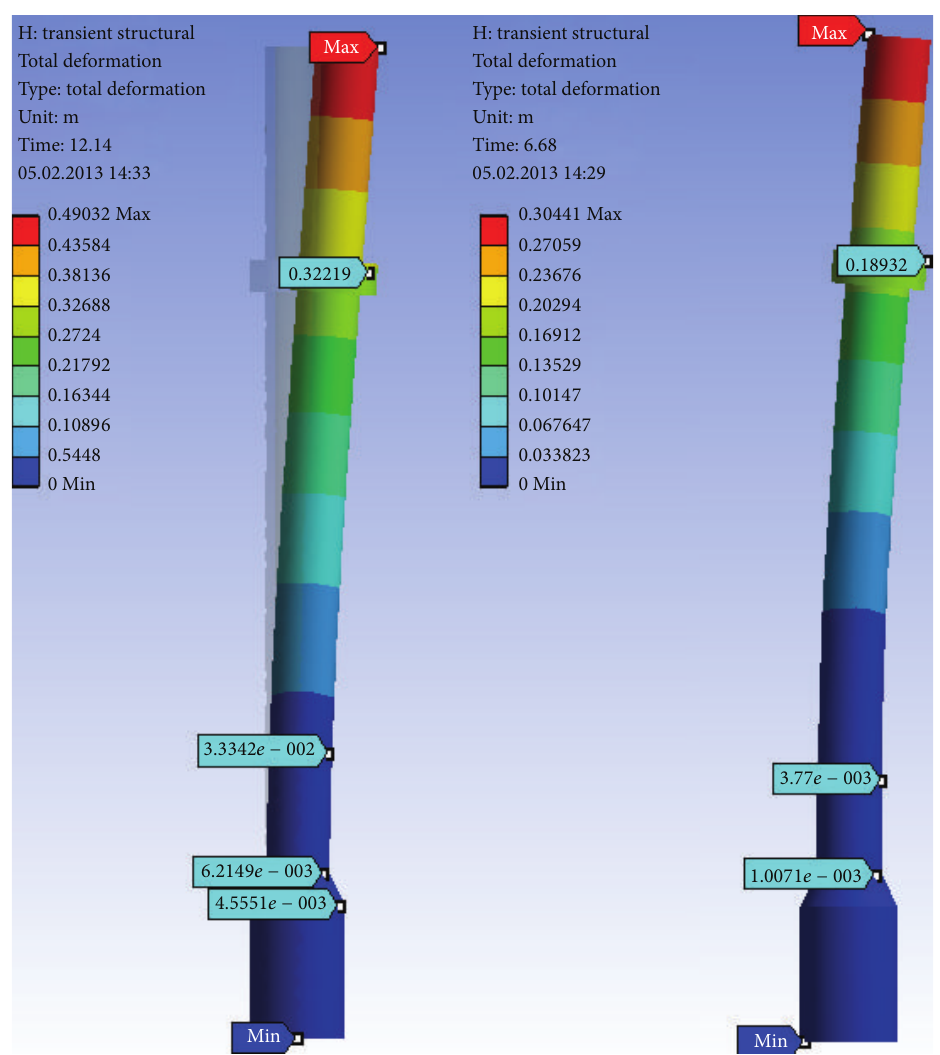
Figure 11: Maximum lateral deformation profiles for scaled Duzce EQ record (left: bare minaret model; right: strengthened model, in